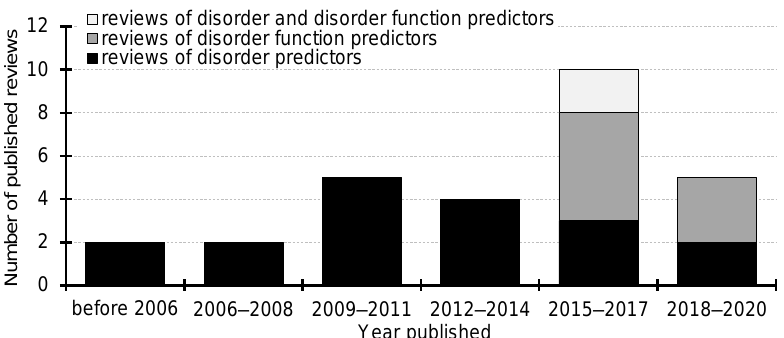
Figure 1. Chronological summary of the past surveys of the intrinsic disorder and intrinsic disorder function predictors.